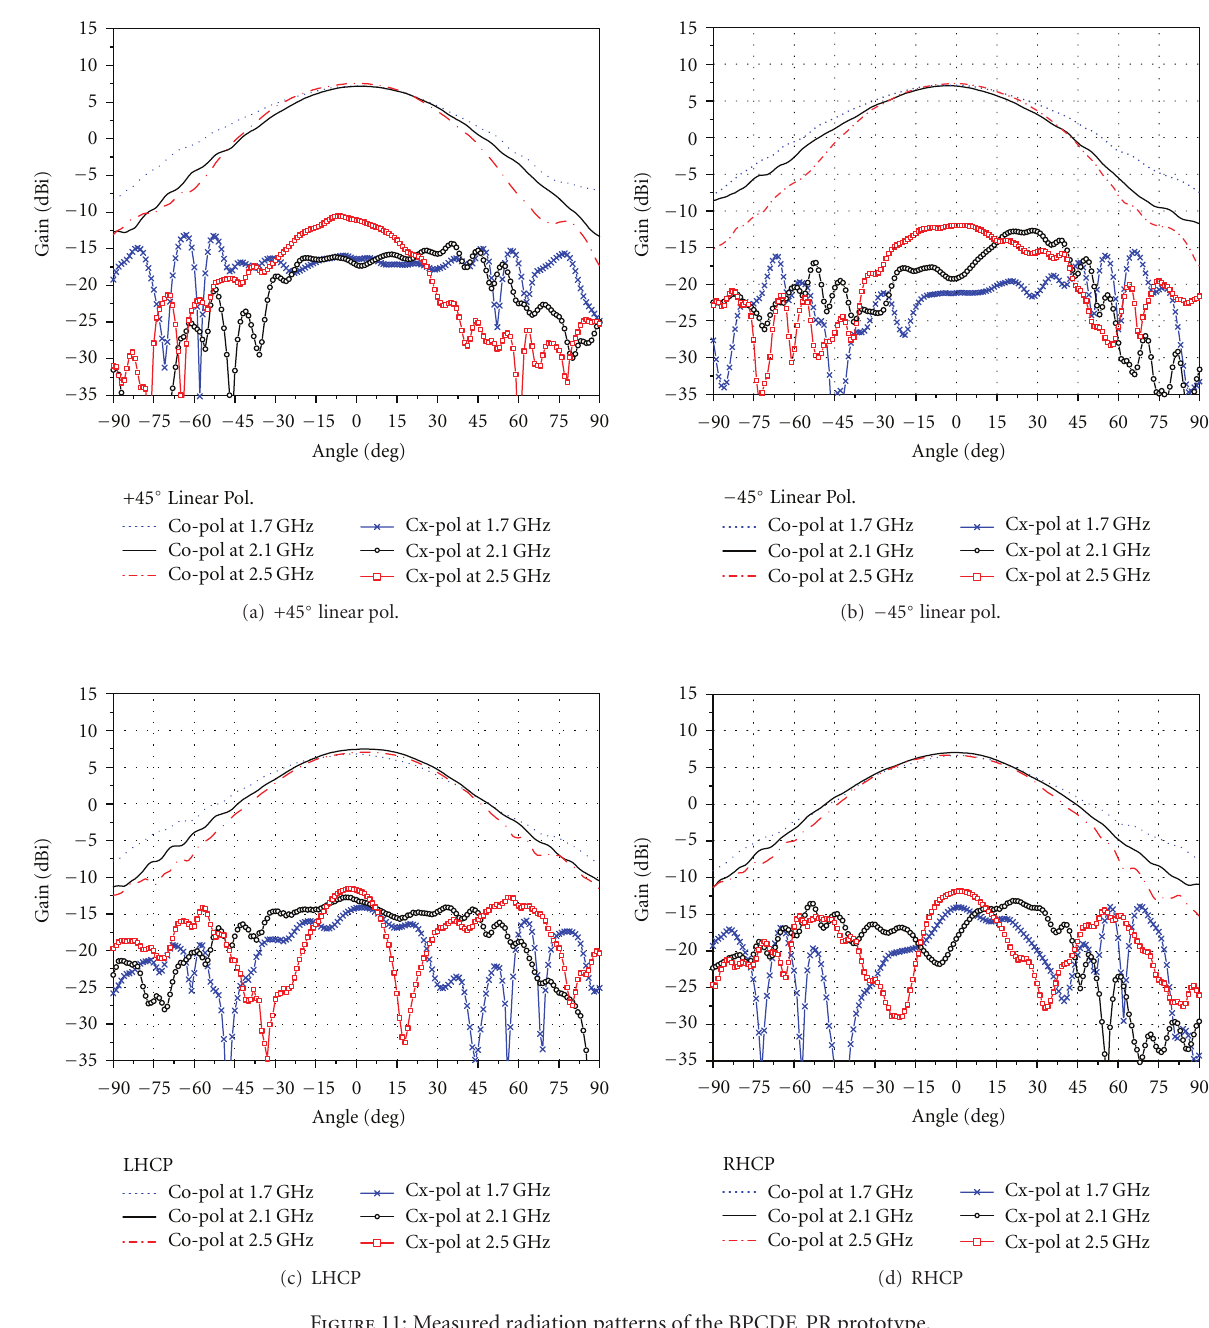
Figure 11: Measured radiation patterns of the BPCDE PR